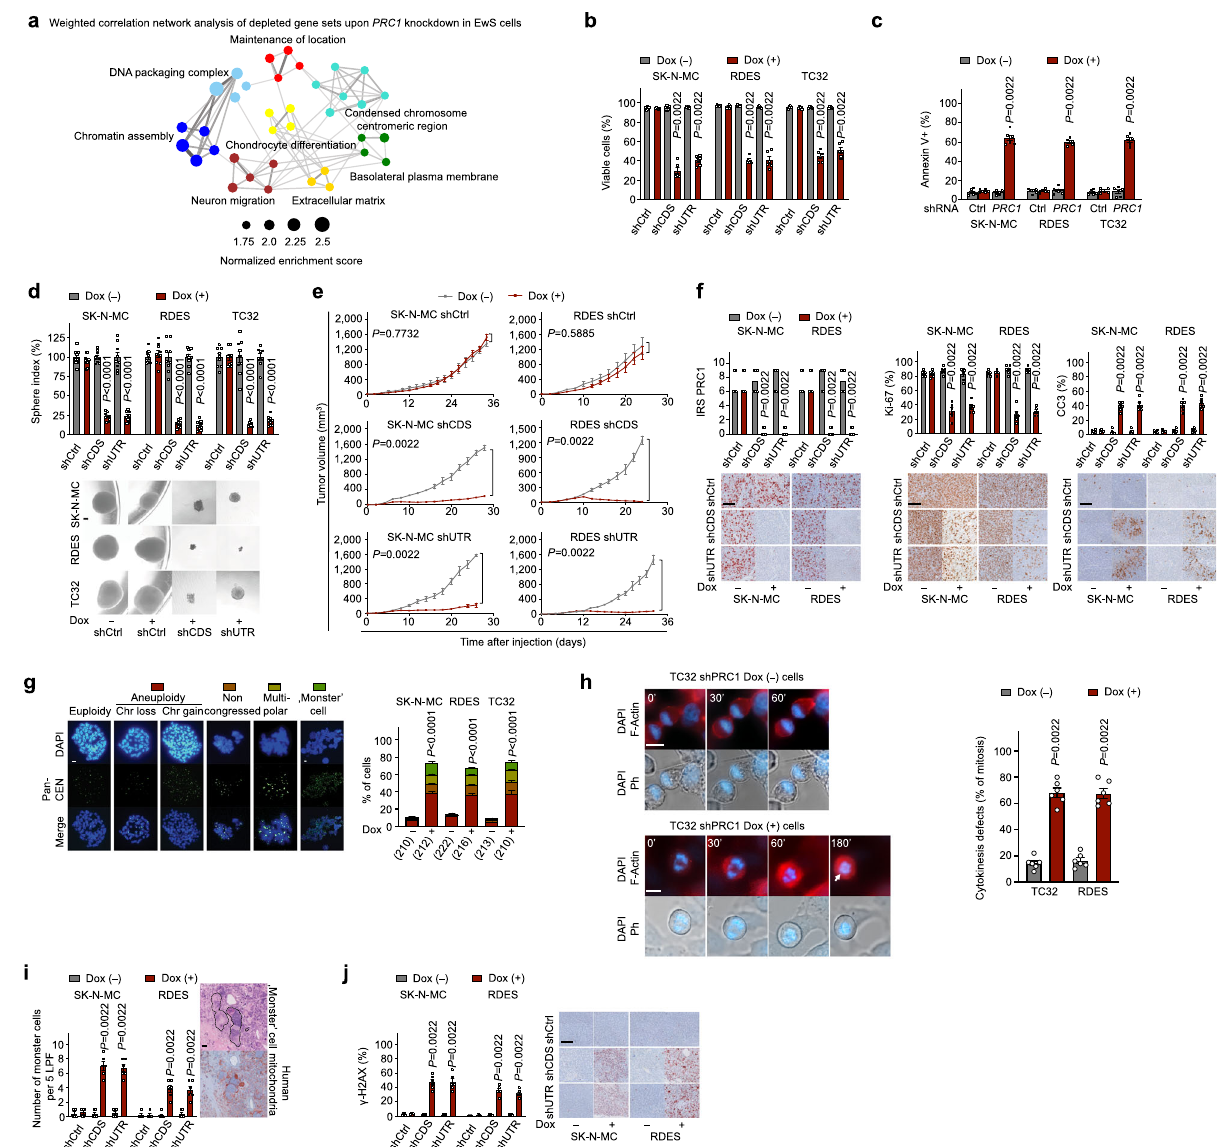
Fig. 3 PRC1 safeguards genome stability in EwS cells. a Transcriptomic network analysis after PRC1 knockdown. b Cell viability 72 h after PRC1 silencing. Data are displayed as individual dots. Horizontal bars represent means and whiskers SEM, n = 6 biologically independent experiments; two-sided Mann- Whitney test. c Analysis of apoptosis (summary of both shPRC1). Data are displayed as individual dots. Horizontal bars represent means and whiskers SEM, n = 6 biologically independent experiments; two-sided Mann-Whitney test. d Sphere-formation after PRC1 knockdown. Data are displayed as individual dots. Horizontal bars represent means and whiskers SEM, n = 9 biologically independent experiments; two-sided Mann-Whitney test. Representative images; scale bar = 50 µ m. e The volume of xenografts with/without PRC1 silencing. Data are mean and SEM, n indicates the number of animals per condition: n = 5 shCtrl and n = 6 shCDS/shUTR in both cell lines. Two-sided Mann-Whitney test. f Representative micrographs and quanti fi cations of PRC1 (IRS), Ki-67, and cleaved caspase-3 (CC3). Data are displayed as individual dots. Horizontal bars represent median IRS of PRC1 or means and whiskers SEM for positivity, respectively; the number of animals per condition is as in e ; two-sided Mann-Whitney test; scale bar = 100 µ m. g Representative images (scale bar = 1 µ m) and quanti fi cation of aberrant metaphases. Horizontal bars represent means and whiskers SEM, n = 6 biologically independent experiments. Parentheses indicate a total number of analyzed mitoses (summary of both shPRC1). Two-sided Chi-squared test. h (Left) Time-lapse images of TC32 cells with/without PRC1 knockdown. F-actin (red), DNA (blue). Arrows = merged nuclei. Scale bar = 10 µ m. (Right) Quanti fi cation of cytokinesis failure (summary of both shPRC1). Data are displayed as individual dots. Horizontal bars represent means and whiskers SEM; n = 6 biologically independent experiments. i Representative micrographs of xenografts (H&E, human mitochondria (mt)), and quanti fi cation of, monster ’ cells per low-power fi eld (LPF). Data are displayed as individual dots. Horizontal bars represent means and whiskers SEM, the number of animals per condition is as in e ; two-sided Mann-Whitney test; scale bar = 20 µ m. j Representative micrographs for γ -H2AX, and quanti fi cation per HPF. Data are displayed as individual dots. Horizontal bars represent means and whiskers SEM, the number of animals per condition is as in e ; two-sided Mann-Whitney test; scale bar = 100 µ m.